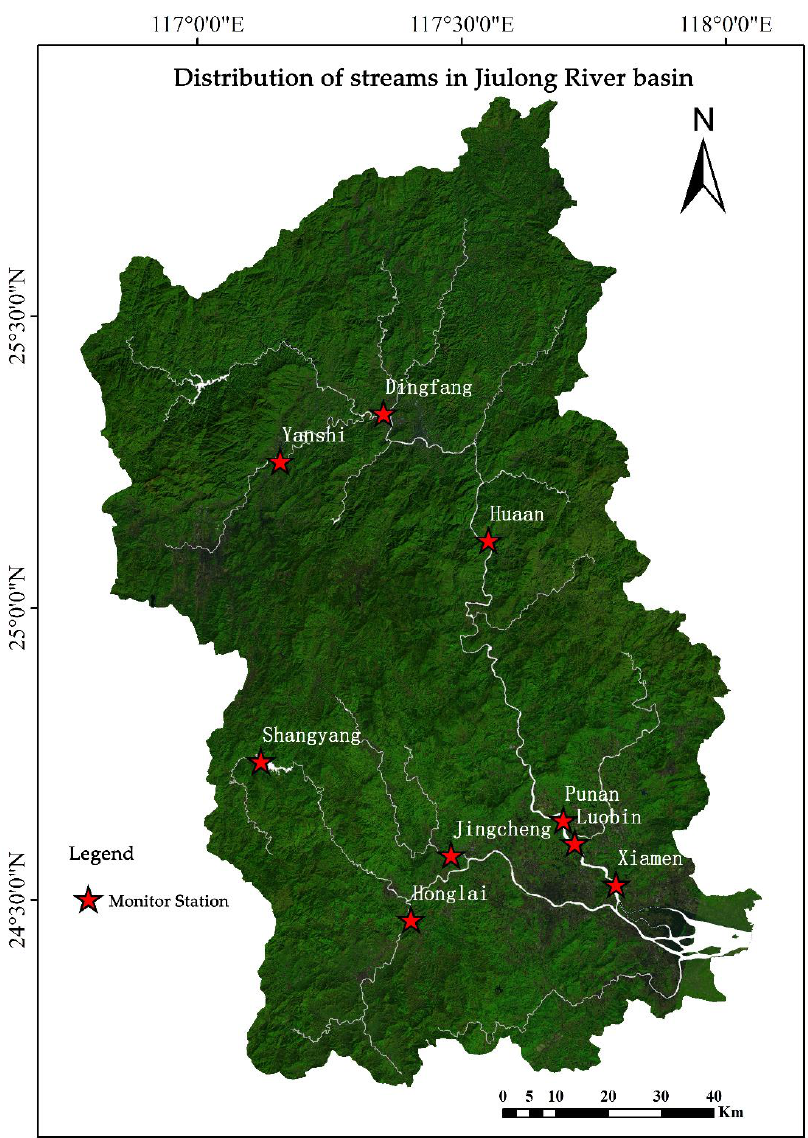
Figure 1. Monitoring sites in Jiulong River basin.